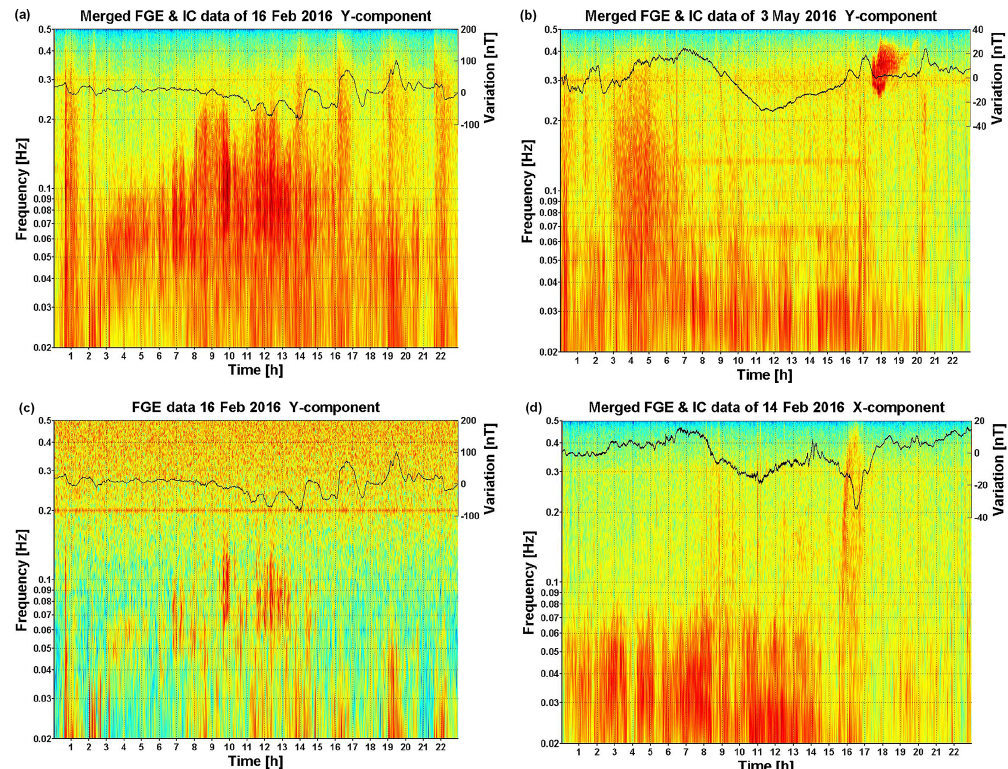
Figure 5. Spectrograms of 3 selected days. Panels (a) and (c) allow for a direct comparison between merged data (a) and fluxgate only (c) . Interesting are the irregular pulsations related to substorm activity in panel (a) , Pc-1 pulsations with clearly defined frequency of 300mHz in panel (b) at 18:00 and pulsation activity with rising frequency starting at 15:30 potentially related to EMIC waves in (d) .